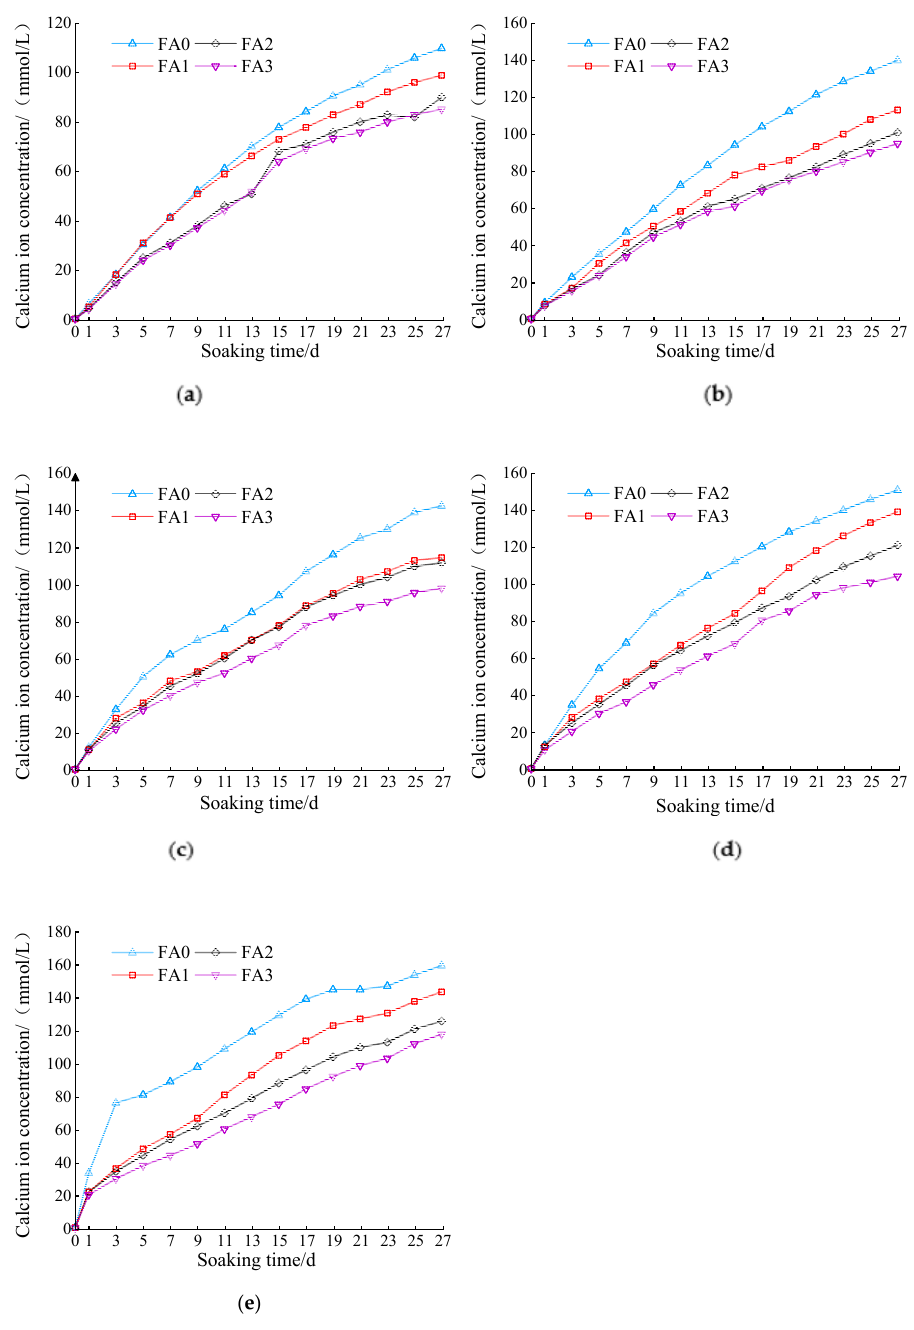
Figure 6. Variation curves of calcium ion concentration at different fly ash contents: ( a ) cement content: 3%; ( b ) cement content: 4%; ( c ) cement content: 5%; ( d ) cement content: 6%; ( e ) cement content: 7%.